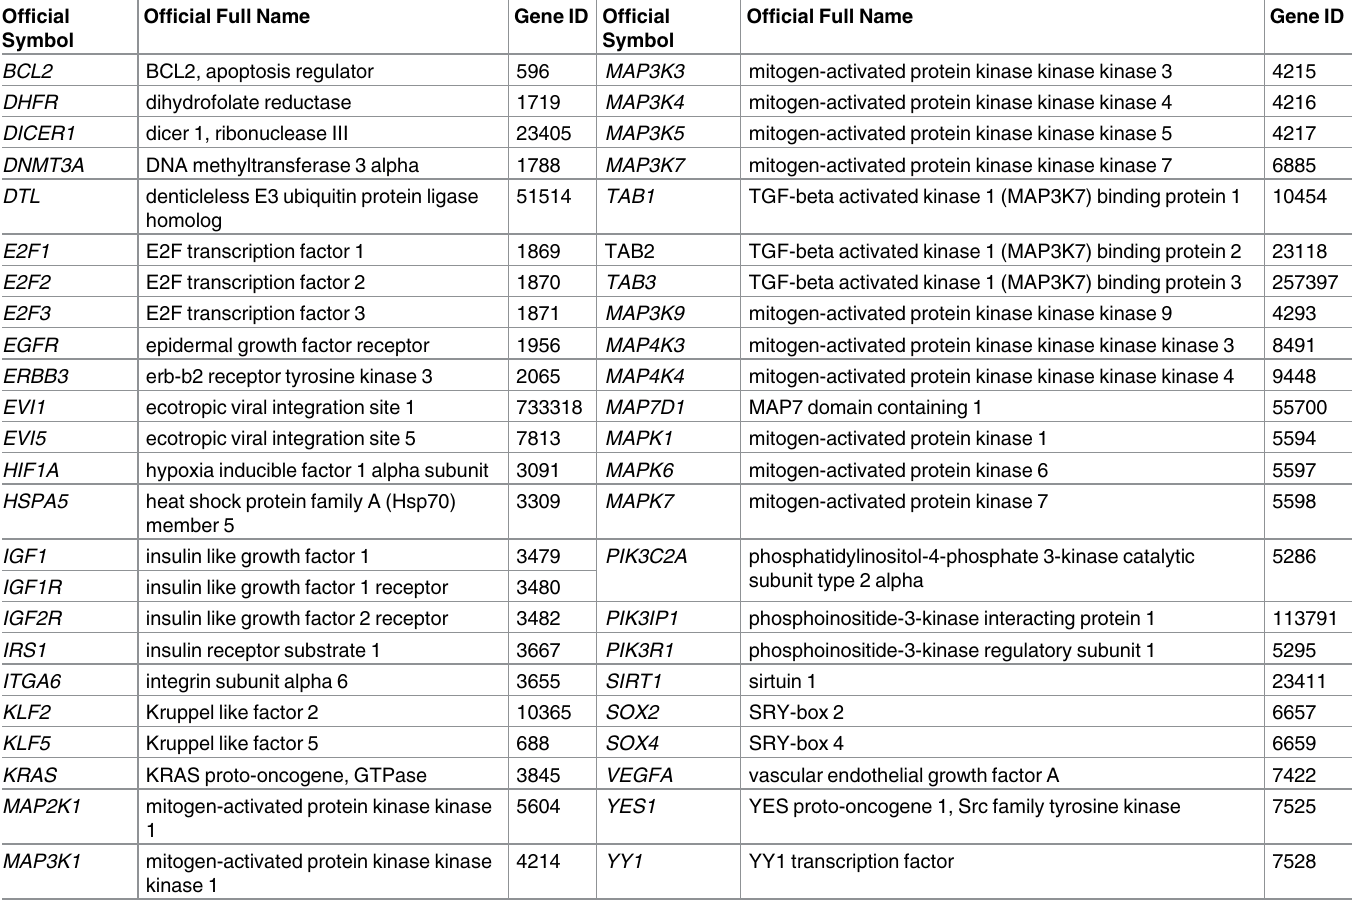
Table 1. List of genes screenedby next-generation sequencing for genetic alterations at miRNA predicted target sites. Official